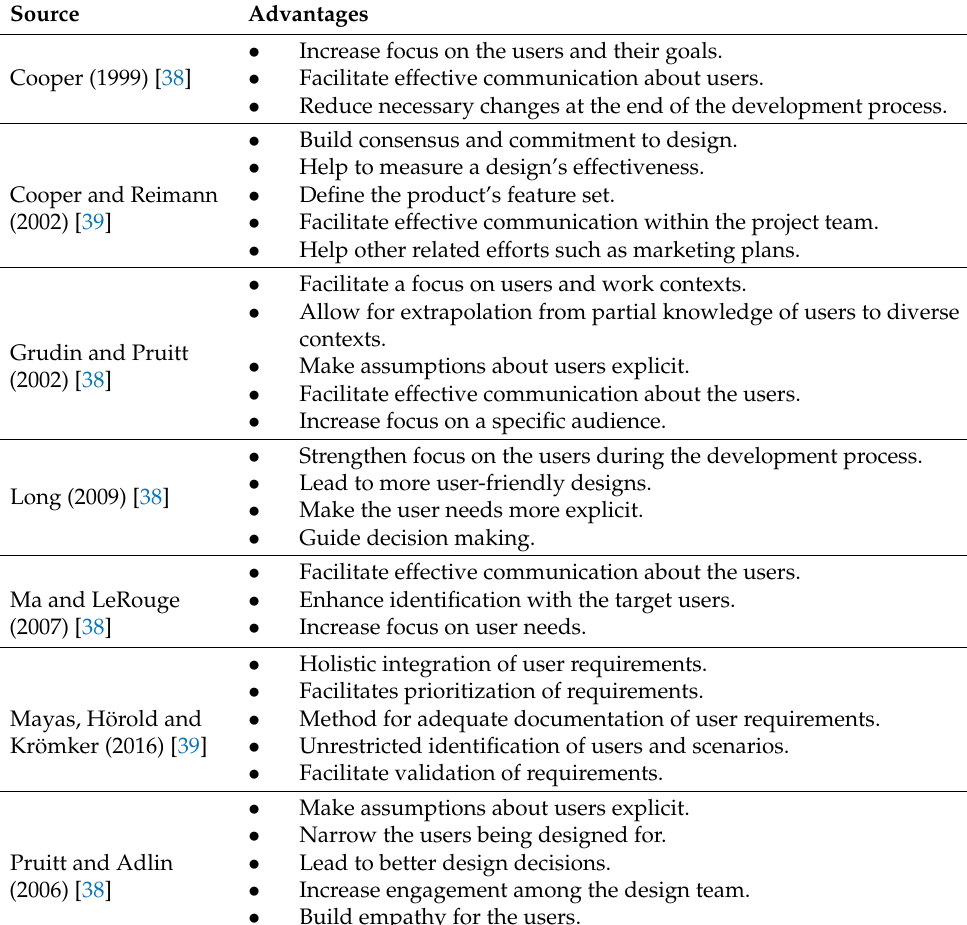
Table 3. Advantages of using